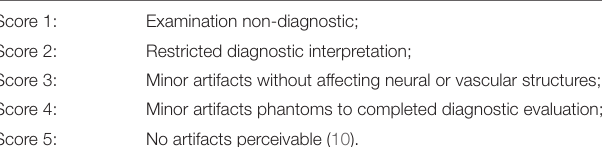
TABLE 1 | 5-point Likert grading criteria.